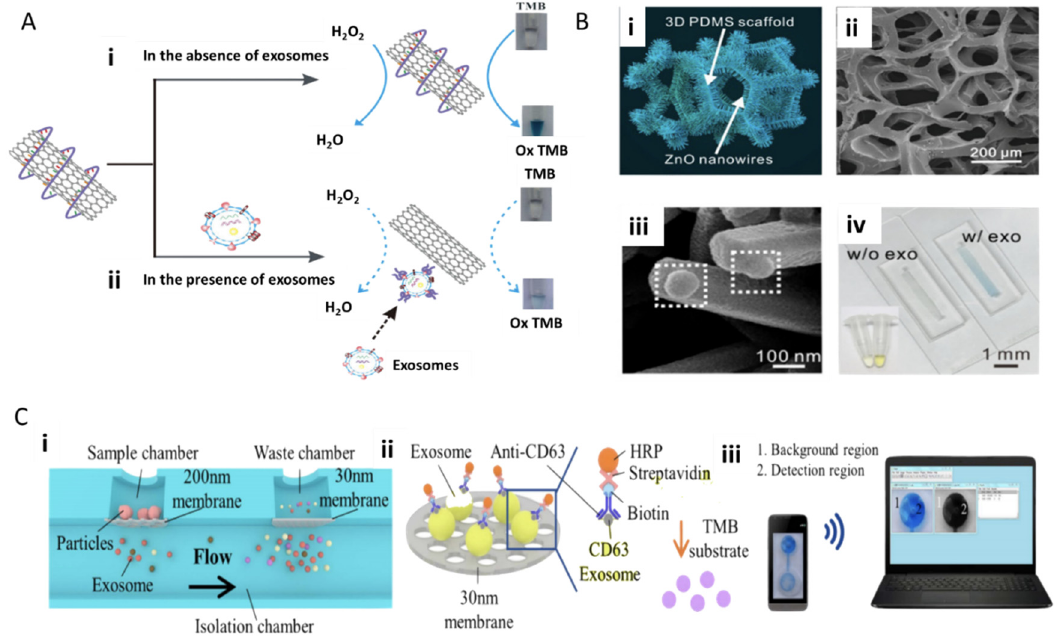
Figure 4. Colorimetric, surface-functionalized biosensing of exosomes. ( A ) Aptamer-based biosensor utilizing single- walled carbon nanotubes (s-SWCNTs) for immunocapture of exosomes with CD63 and subsequent colorimetric 3,3 ′ ,5,5 ′ -tetramethylbenzidine (TMB) assay. ( Bi ) ZnO-based biosensor applying ZnO nanowires, polydimethylsiloxane (PDMS) scaffold structure with ZnO nanocrystals forming nanowires. ( Bii ) SEM of ZnO nanowires on the scaffold. ( Biii ) SEM image of exosome capture. ( Biv ) Colorimetric assay example with and without exosomes with sandwiched immunocapture of CD9 and CD63 functionalized ZnO nanowires (reprinted with permission from Copyright Clearance (2016) and (2017) Elsevier). ( Ci ) Schematic of a double-filtration microfluidic device for size-based exosome isolation featuring the initial 200 nm membrane and subsequent 30 nm membrane. ( Cii ) Schematic of direct enzyme-linked immunosorbent assay (ELISA) for extracellular vesicle (EV) detection with on-chip ELISA. ( Ciii ) Detection of colorimetric HRP-TMB interaction with smartphone and computer. Reprinted with permission from Copyright Clearance (2017) Nature Scientific Reports.